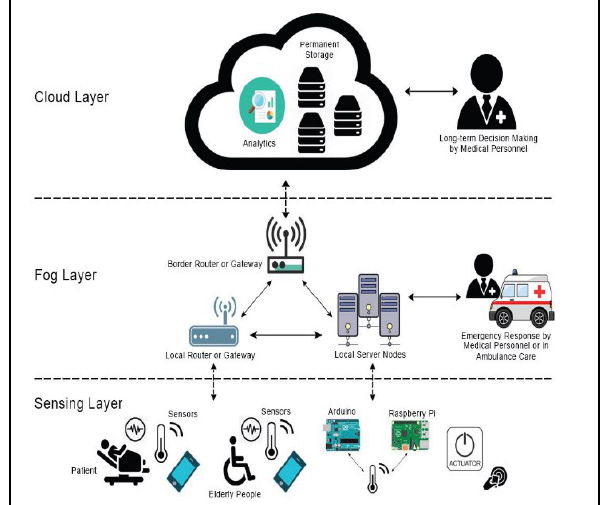
Figure 1: Smart healthcare system architecture (Naresh et